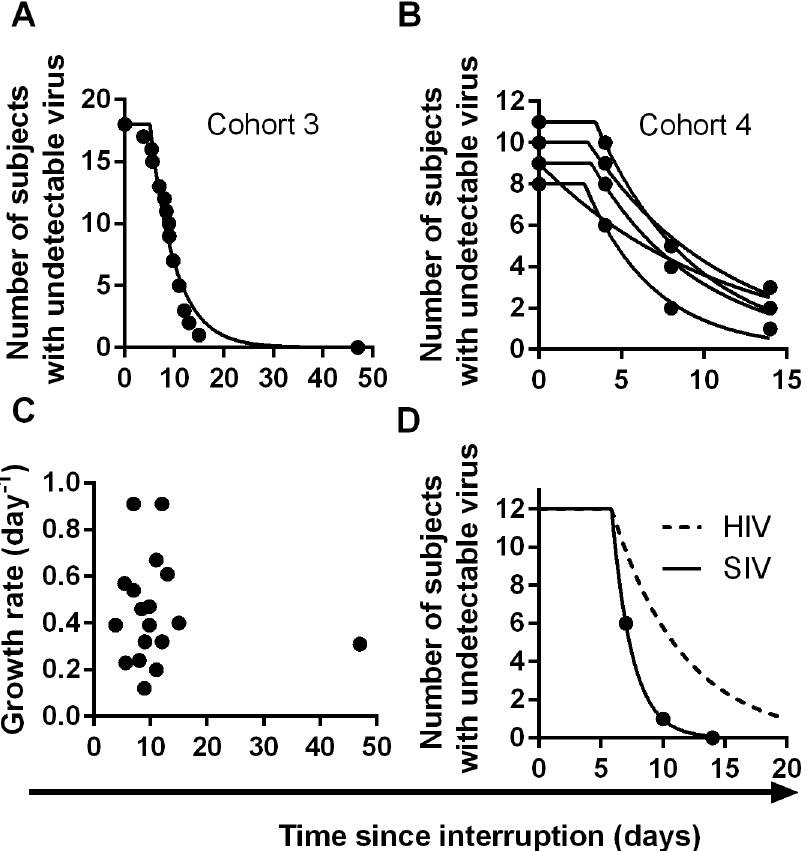
recrudescence is not correlated with growth rate in cohort 3. (D) Higher reactivation rates in SIV than HIV. The estimated frequency of initiation of viral replication in SIV infected macaques treated with ART between 7 and 14 days post-infection (from reference [26]) is shown as solid line, and was found to be once every 1.7 days. The best-fit frequency of reactivation across the four HIV cohorts (a reactivation event every 6 days) is shown as a dashed